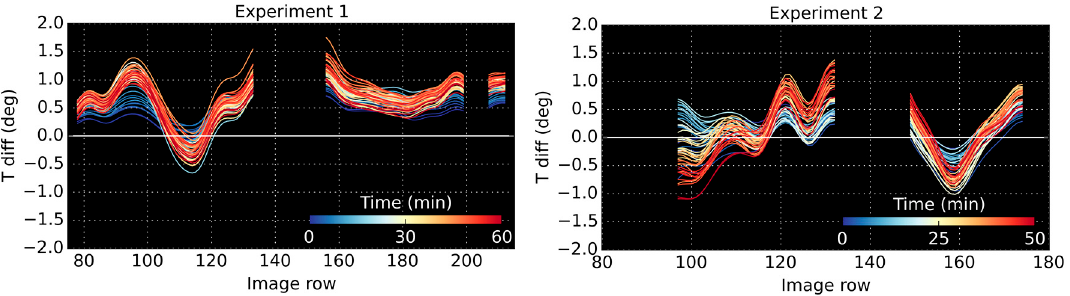
Figure 9. Temperature difference between stressed and control plants calculated from average derived for each image row.